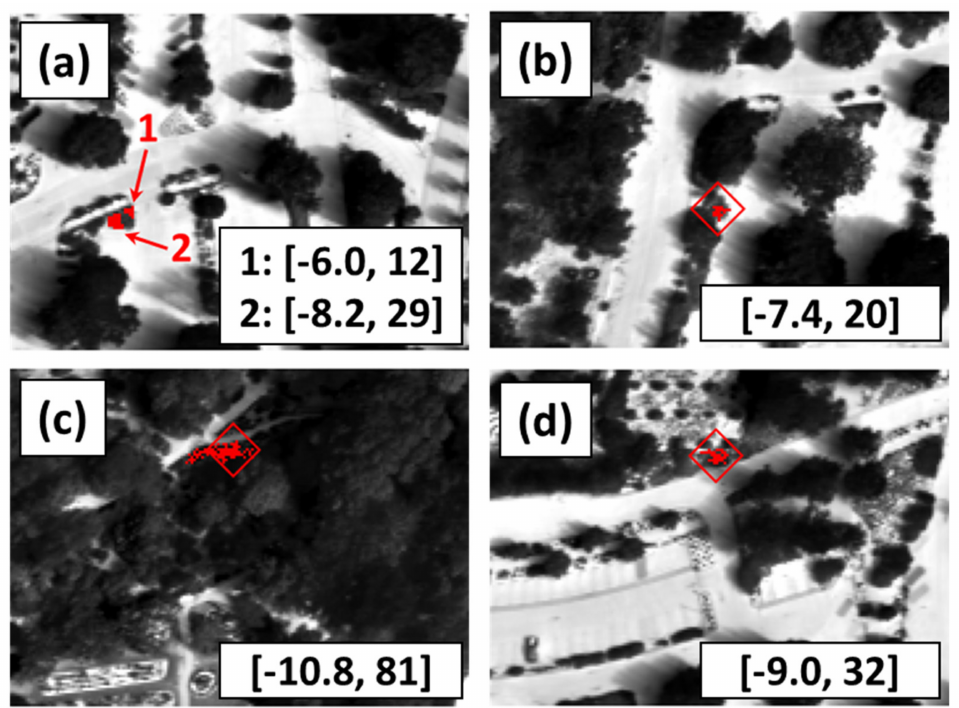
Figure 11. Sampling of Salvia spp. IDs at the Huntington Botanical Gardens: ( a ) 1: S. chamaedryoides ; 2: S. leucophylla ‘Bee’s Bliss’, ( b ) S. clevelandii , ( c ) S. fruticosa and S. heldreichiana , ( d ) S. clevelandii x S. leucophylla ‘Pozo